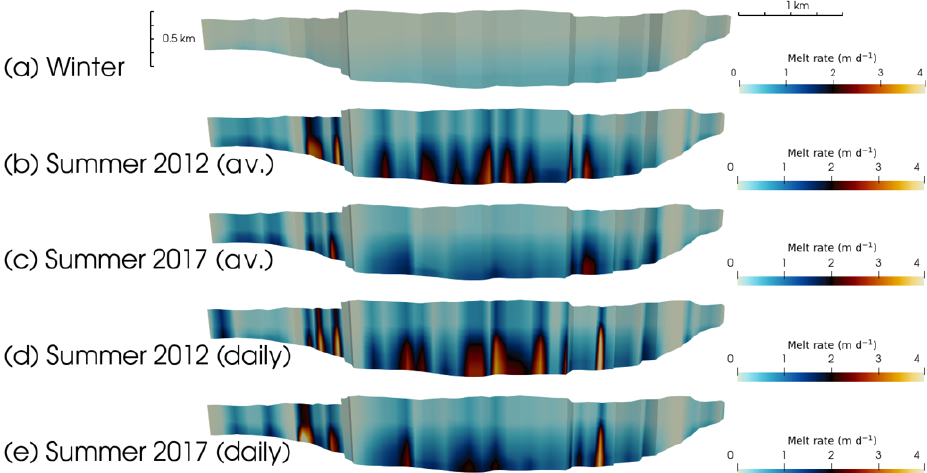
Figure 4. Patterns of typical plume-generated frontal melt across all simulations, showing the 9 August for panels (b) – (e) . (a) Winter run; (b) SummerAverage12 (average-forced) run; (c) SummerAverage17 (average-forced) run; (d) SummerDaily12 (daily-forced) run; (e) Sum- merDaily17 (daily-forced) run. North is to the left, and south is to the right. Note how higher summer plume activity is concentrated into a relatively small number of localised high-melt plumes.